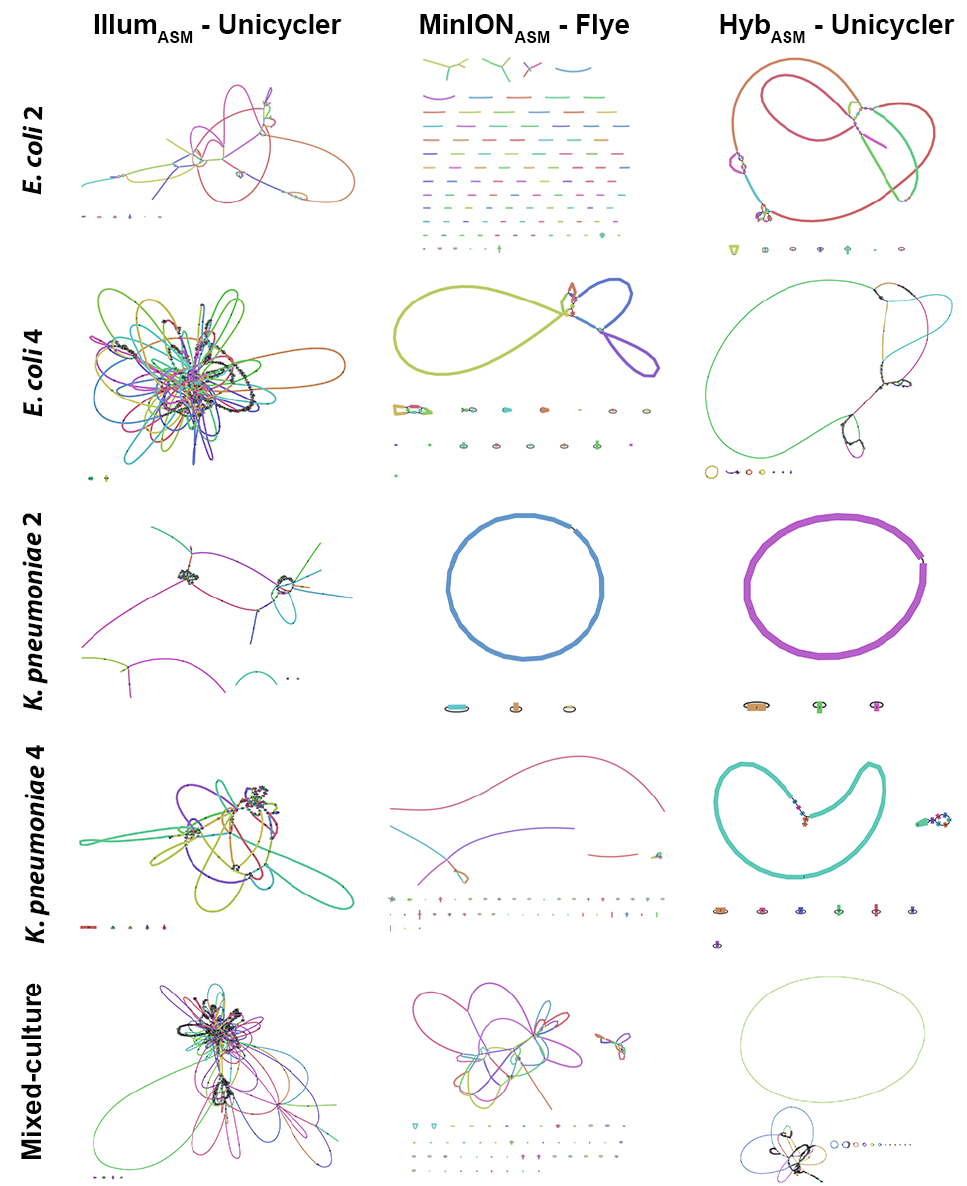
Figure 2. Representative assembly graphs for some of the isolates including E. coli 2 and 4, K. pneumoniae 2 and 4 as well as a mixed sample from the co-culturing of E. coli 4 and K. pneumoniae 5 isolates. The GFA files produced by the top-performing assemblers (Unicycler for Illumina short reads, Flye for MinION long reads and Unicycler for hybrid reads) were used to construct the assembly graphs using Bandage. Illumina assemblies were fragmented, and putative plasmids were limited. MinION produced much larger contigs and more putative plasmids. However, proper circular chromosomes were not observed for the majority of isolates using either Illum ASM or MinION ASM . However, hybrid assemblies provided us with clear and close chromosome/putative plasmids.